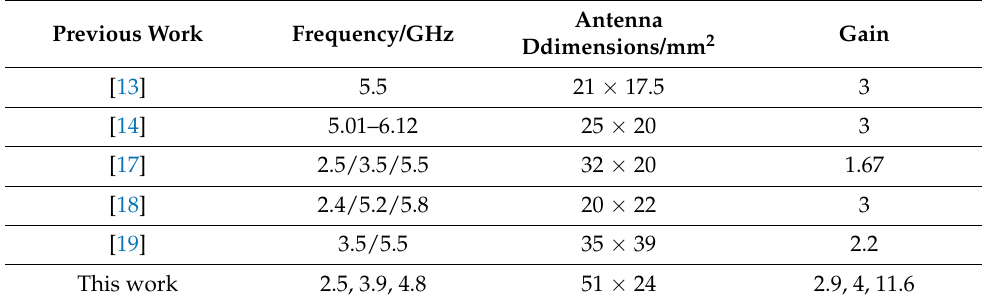
Table 4. Comparison between this work and previous